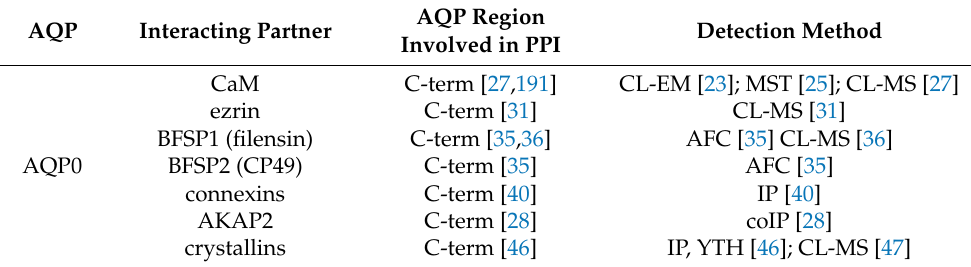
Table 1. AQP interacting